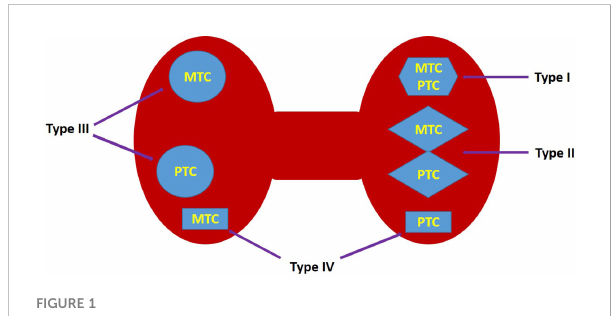
FIGURE 1 Synchronous tumors were divided into 4